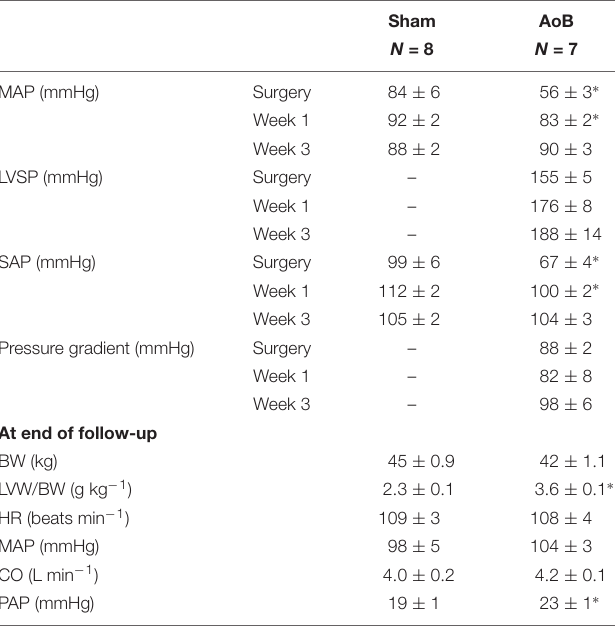
TABLE 2 | Anatomic and hemodynamic